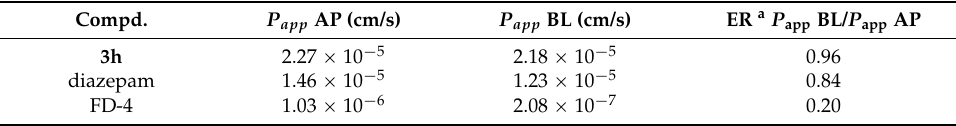
Table 2. Bi-directional transport of 3h and control compounds across Madin-Darby canine kidney (MDCK)II-MDR1